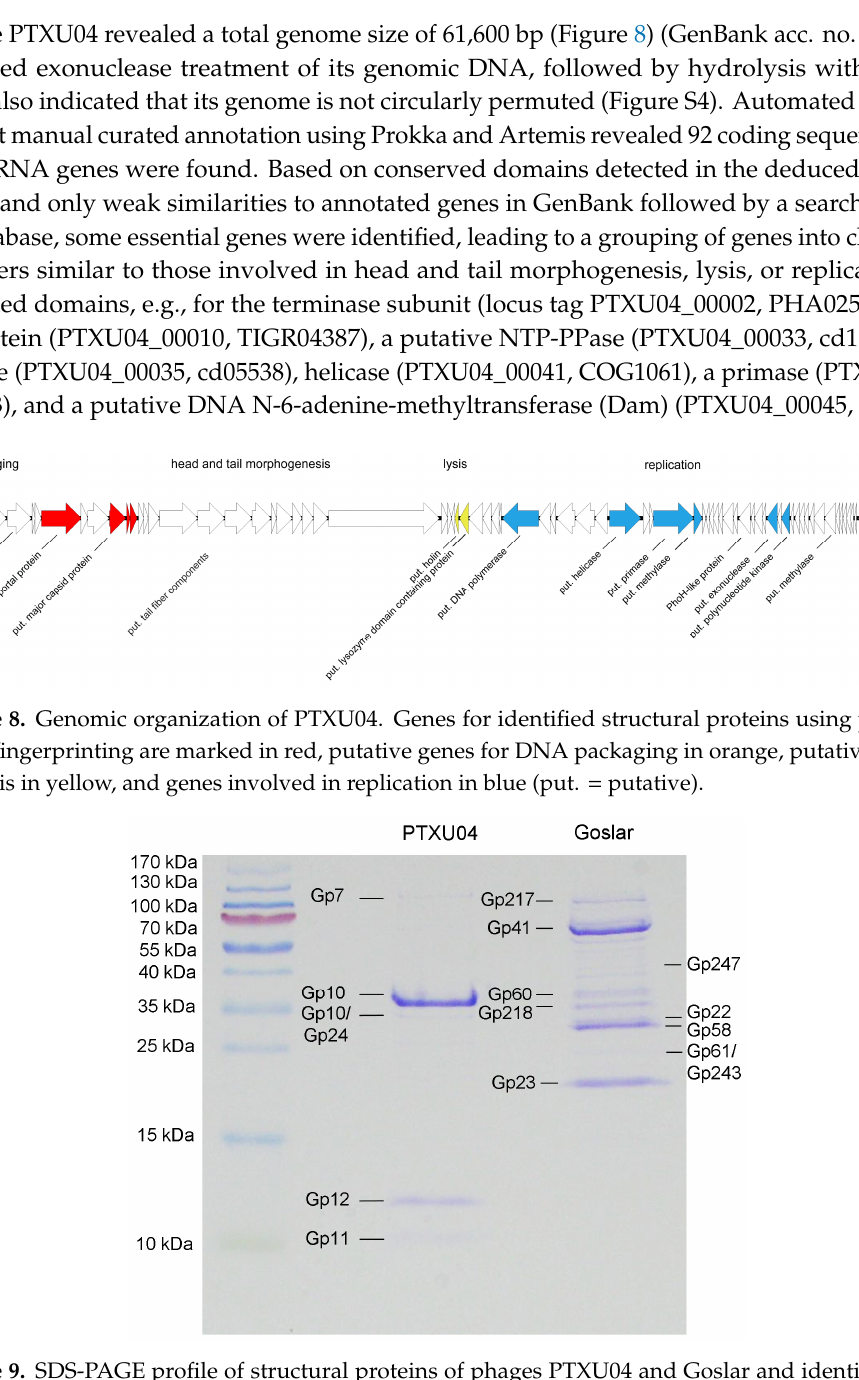
Figure 9. SDS-PAGE profile of structural proteins of phages PTXU04 and Goslar and identification via mass peptide fingerprinting. Proteins were separated by 15% SDS-PAGE. After extraction of gel bands and tryptic digestion, samples were analyzed via peptide mass fingerprinting. Identified gene products are